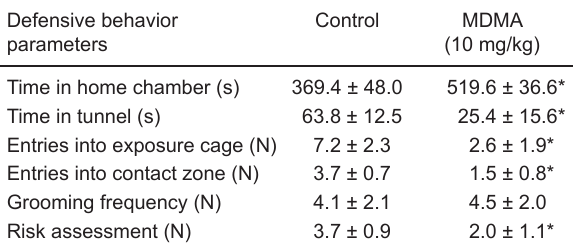
Table 3. Effects of 3,4-methylenedioxymethamphetamine (MDMA, 10 mg/kg) on defensive behavior on BALB/c male mice in response to cat odor 60 min after